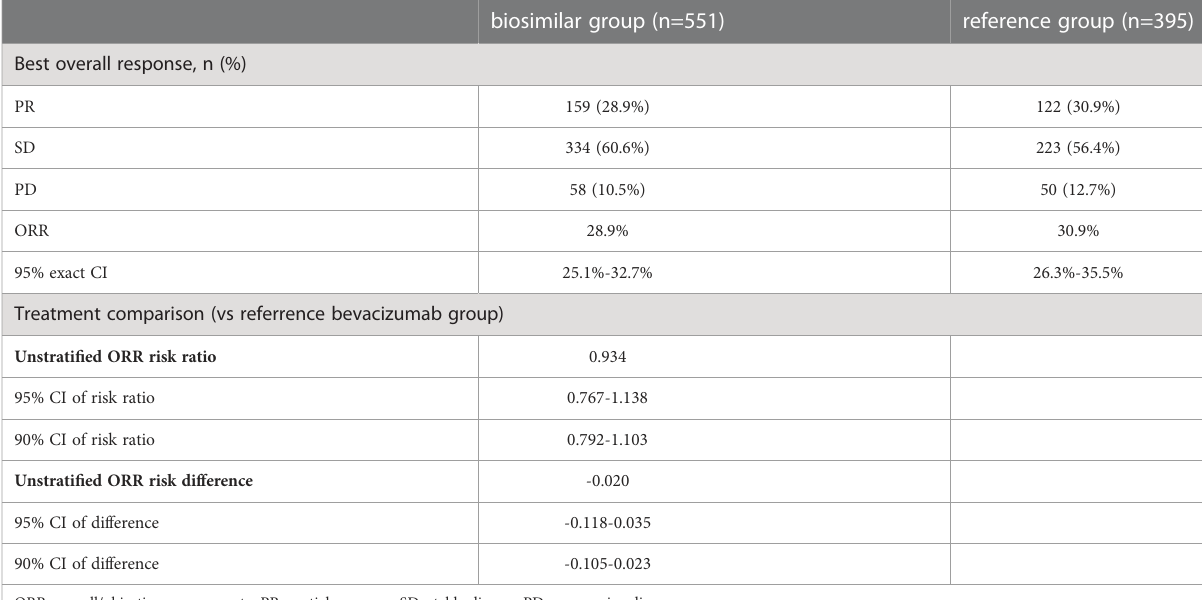
TABLE 2 Comparison of overall response rate between biosimilar and reference